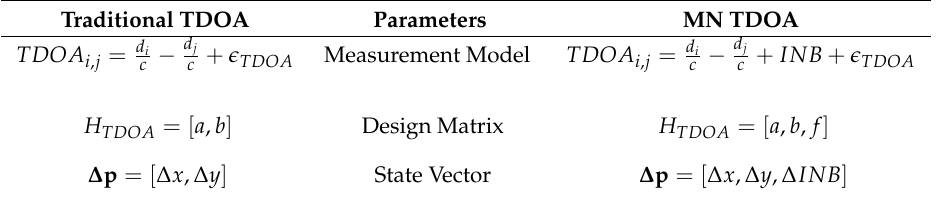
Table 1. Main differences between the Traditional and the proposed MN TDOA algorithms.